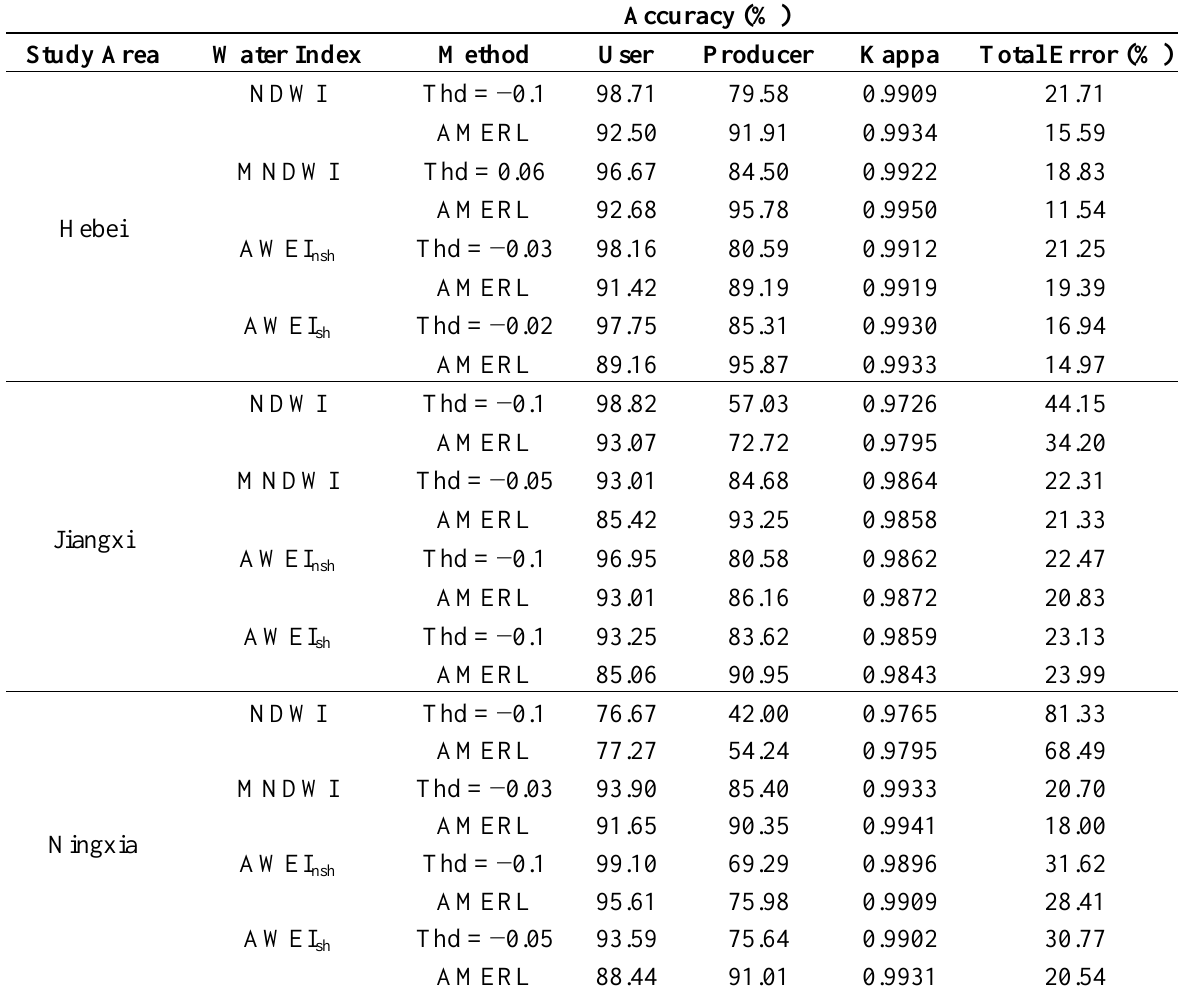
Table 4. Accuracies of water body extraction using the optimal thresholding method and the AMERL for the four water